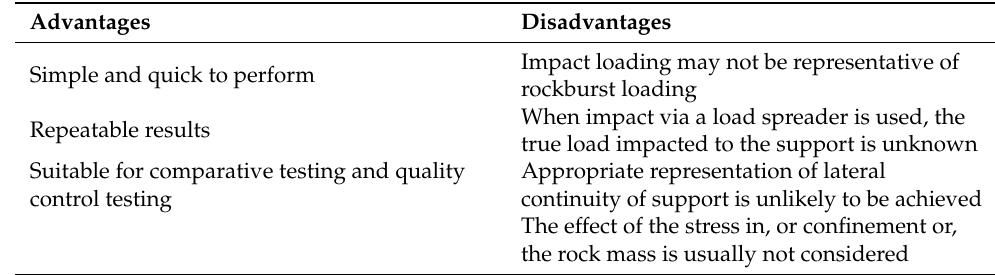
Table 1. Advantages and disadvantages of drop